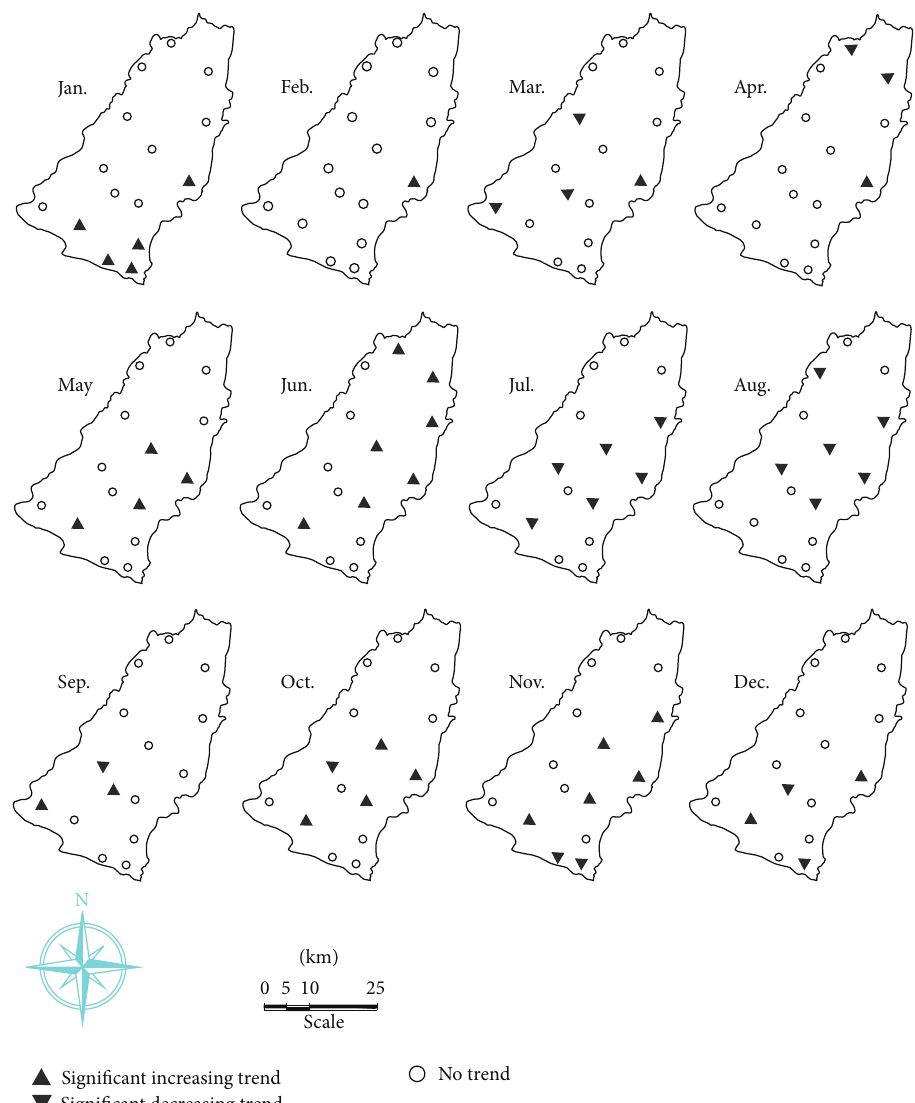
Figure 3: Location of sites with increasing, decreasing, and no trends at 5% significance level for the monthly precipitation time